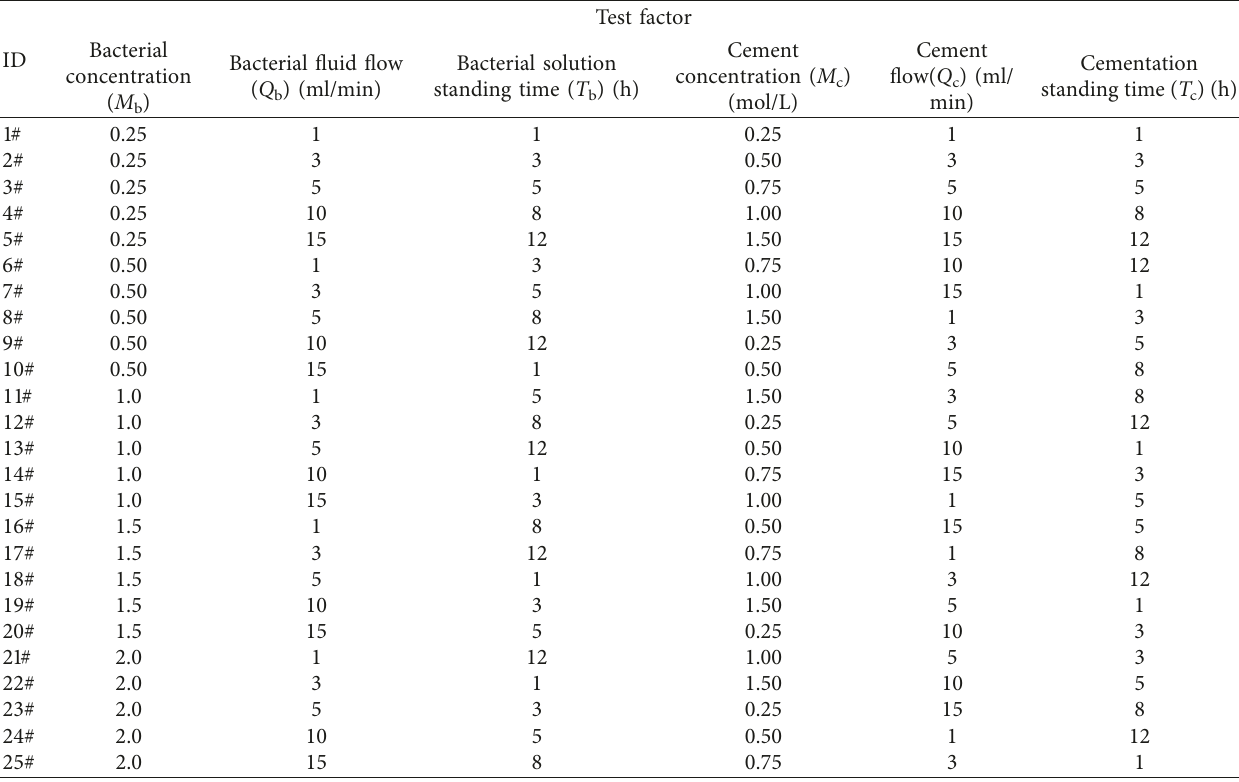
Table 2: Orthogonal design test